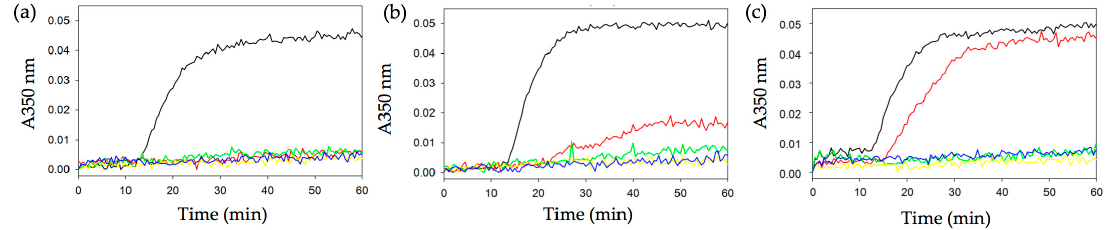
Figure 4. In vitro tubulin polymerization. Turbidity assays for the assembly of 20 µM tubulin at 37 °C in the presence of QA 1 ( a ), QA 2 ( b ), and QA 3 ( c ) followed at 350 nm. Black line, DMSO vehicle; red line, 2 µM QA; green line, 5 µM QA; yellow line, 10 µM QA; blue line, 25 µM QA.